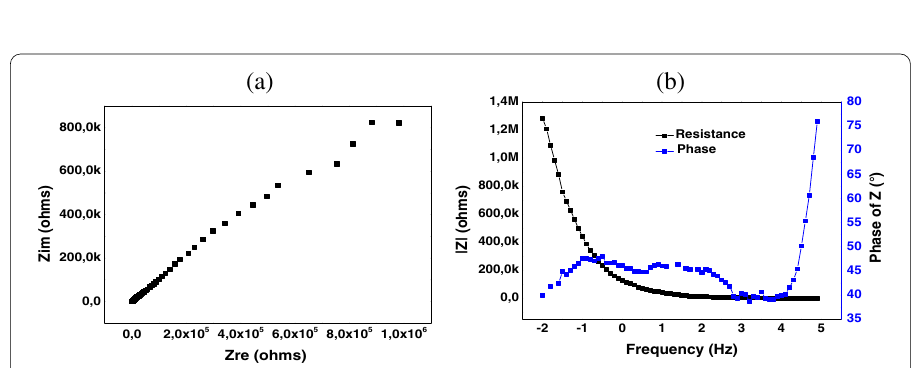
Fig. 12 The impedance curve of the spisment treated with three steps according to the representation of a Nyquist plots and b Bode plots in 3.5%